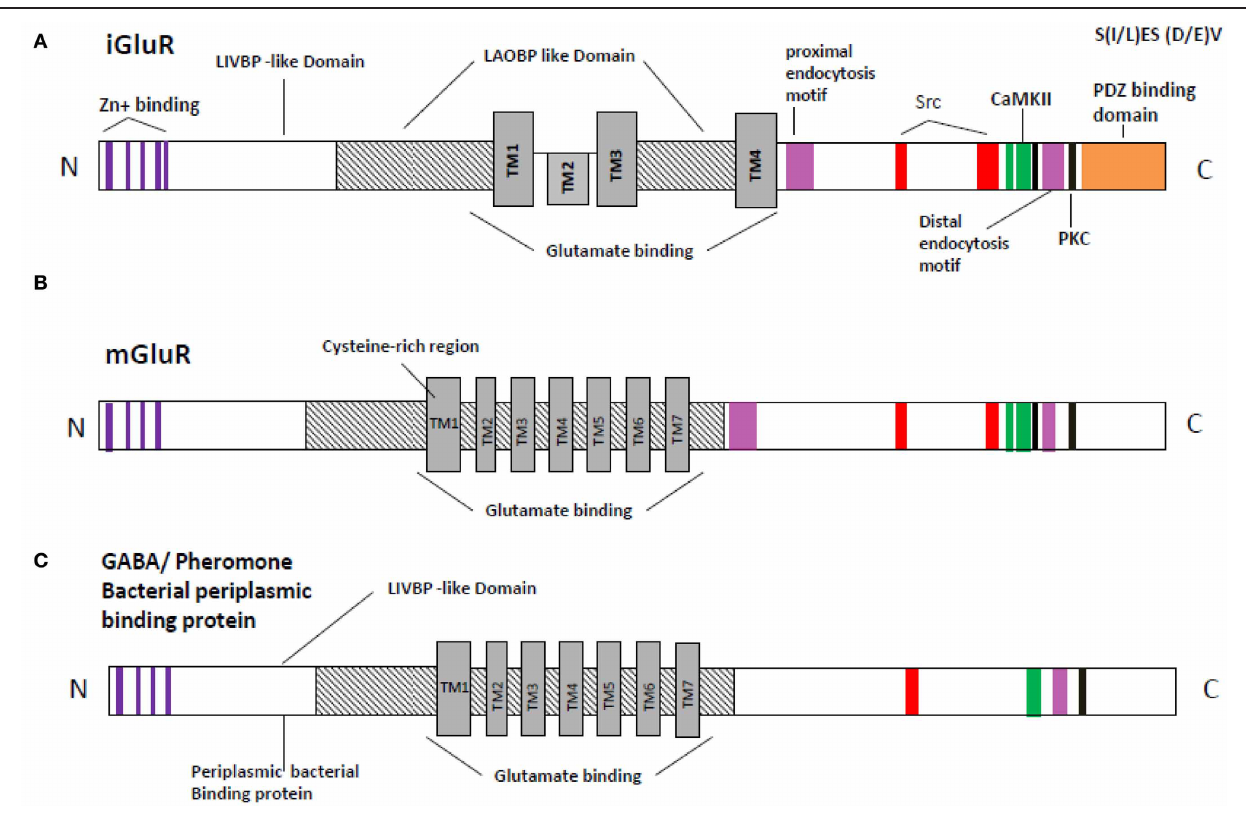
et al. (2000)]; Red, Src binding domain [according to Schumann et al. (2009) and Nakazawa et al. (2001)]; Lavender, proximal endocytosis motif; Delphinium, Zing binding domain; TM1–TM7, Trans membrane domain 1–7; LAOBP, lysine-arginine-ornithine binding protein; LIVBP, Leucine/isoleucine/ ornithine binding protein region are predicated accordingly Ryan et al.